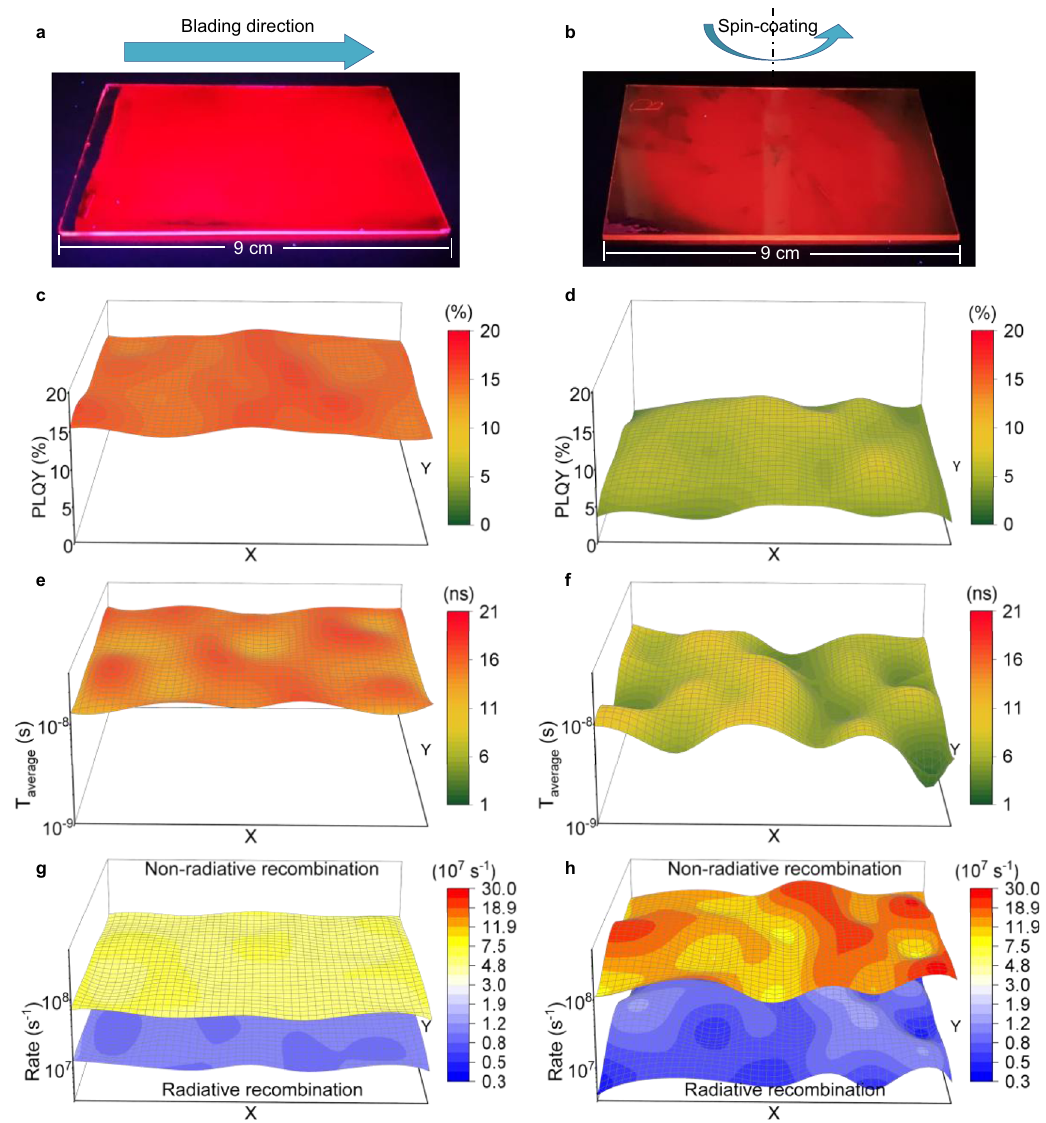
Fig. 4 Optoelectronic characterizations of large-area perovskite fi lms. a , b PL images of the large-area perovskite fi lms fabricated by doctor-blading ( a ) and spin-coating ( b ). The fi lm area is 6 × 9 cm 2 . c – h PLQY ( c , d ), T average ( e , f ), and radiative and non-radiative recombination rate ( g , h ) mapping of large- area fi lms fabricated by doctor-blading ( c , e , g ) and spin-coating ( d , f , h ). The excitation wavelength and intensity for PLQY (TRPL) are 430 nm (369 nm) and 8 mW/cm 2 (6 mW/cm 2 ), respectively. The characterizations are performed on small-area fi lms (56 fi lms in total). The three-dimensional fi gures are plotted by spatial